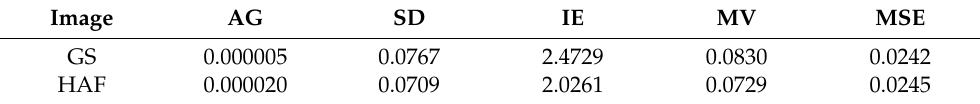
Table 4. Accuracy evaluation results for different thresholds.